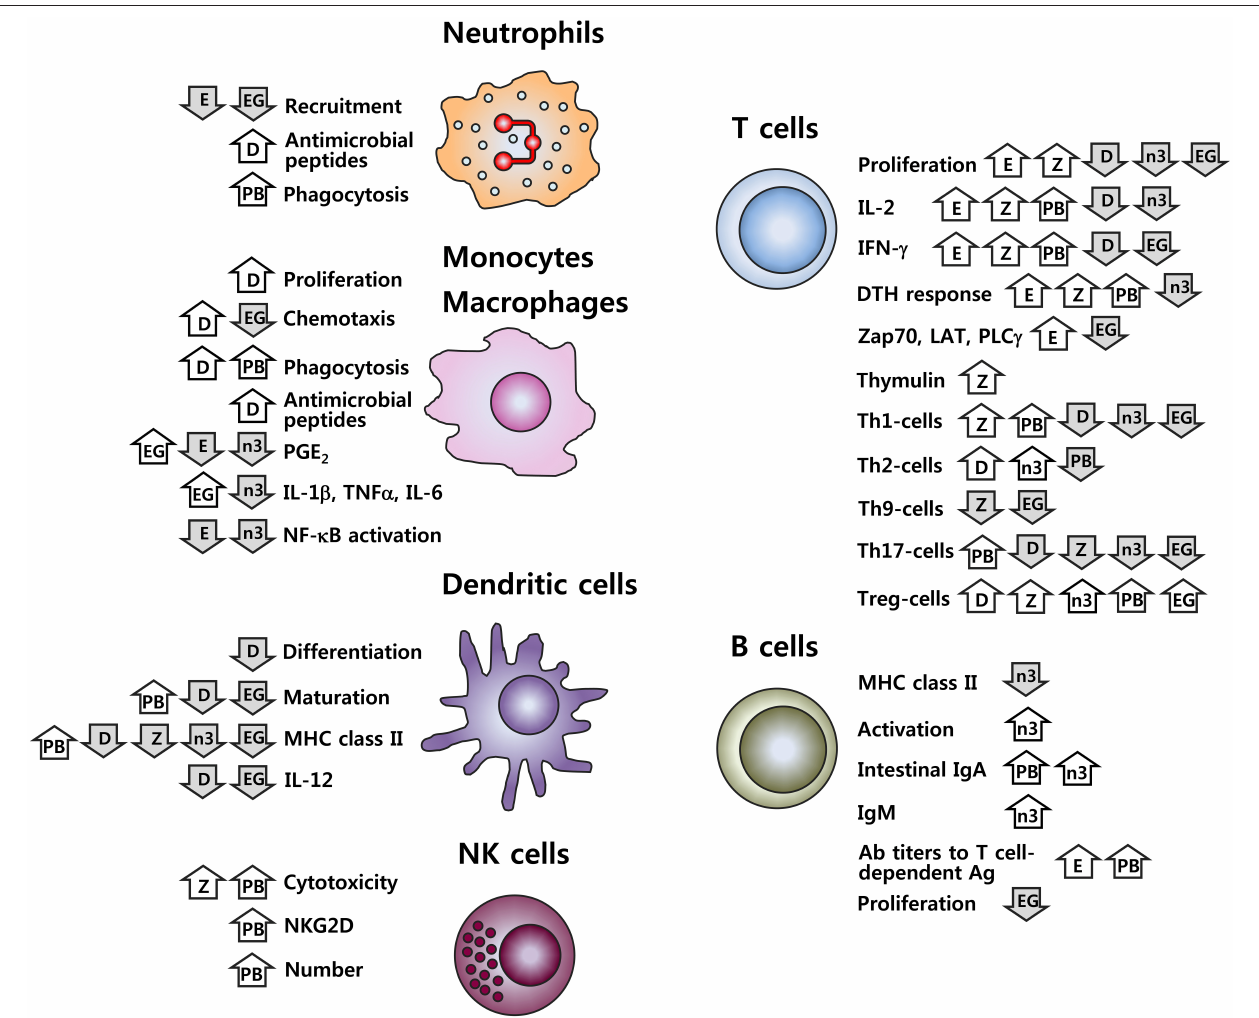
FIGURE 1 | Immune cell functions affected by vitamins D and E, zinc, n-3 PUFA, probiotics, and EGCG. D, vitamin D; E, vitamin E; Z, zinc; n-3, n-3 PUFA; PB, probiotics; EG, EGCG; , increase; , decrease. Effects of probiotics cited here are for some strains; given the strain-specific nature for the effects of probiotics, these results should not be